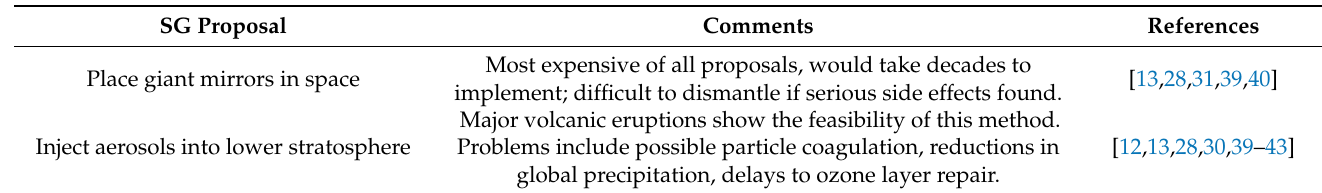
Table 1. Summary of solar geoengineering